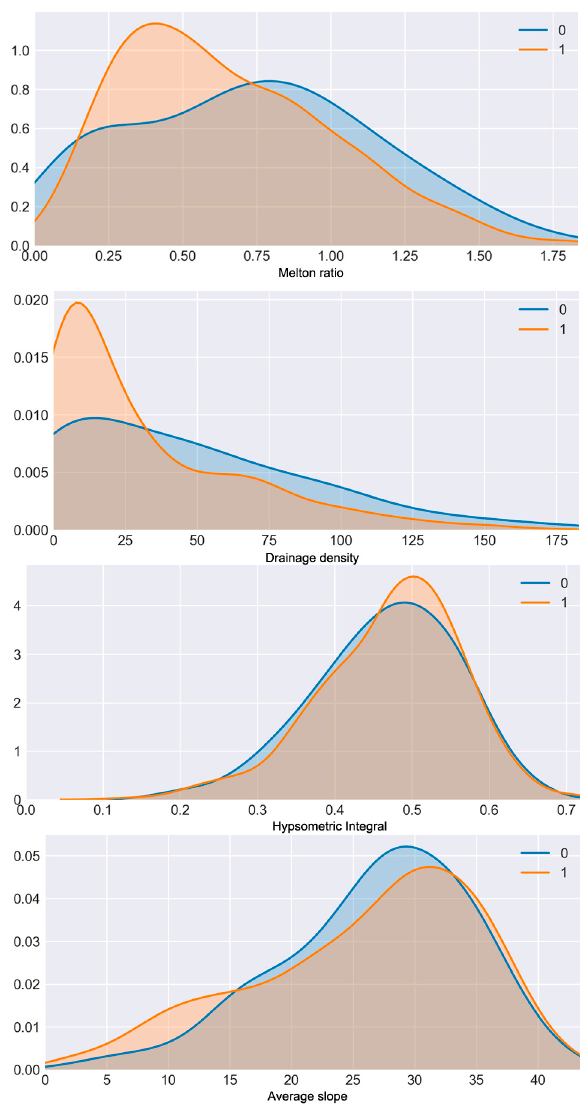
Figure 12. Distribution of MR , DD , HI , and AS . “1” indicates catchments prone to debris flow, and “0”